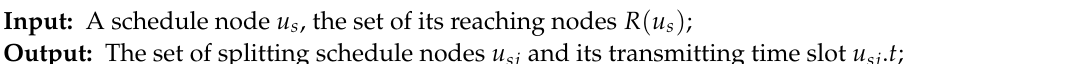
Algorithm 1 Transmitting time slot-determining